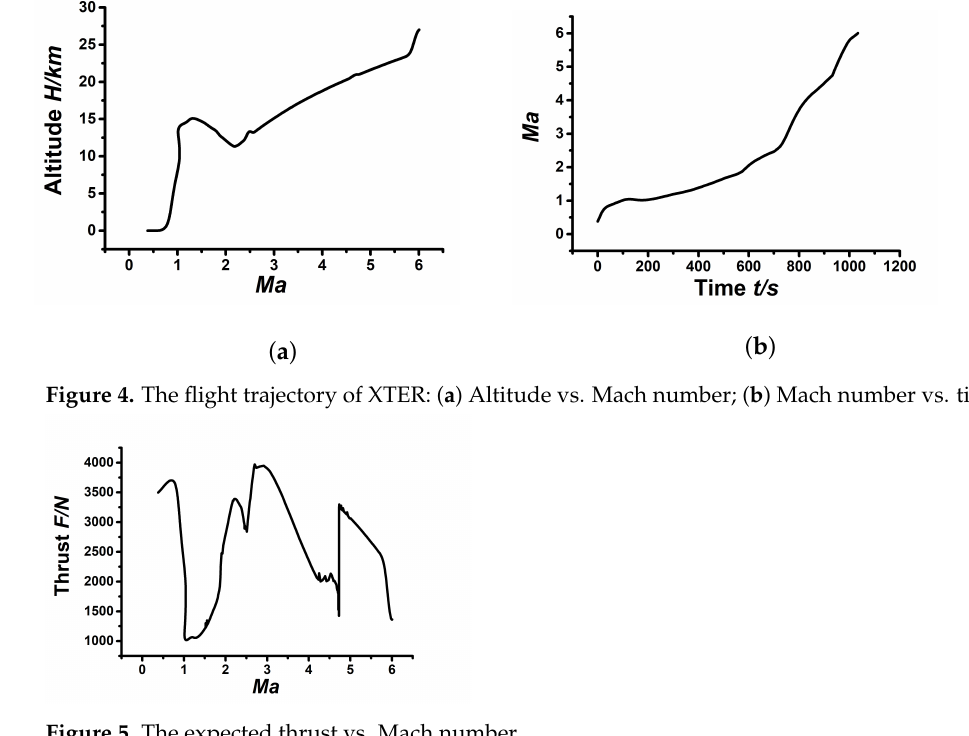
Figure 5. The expected thrust vs. Mach